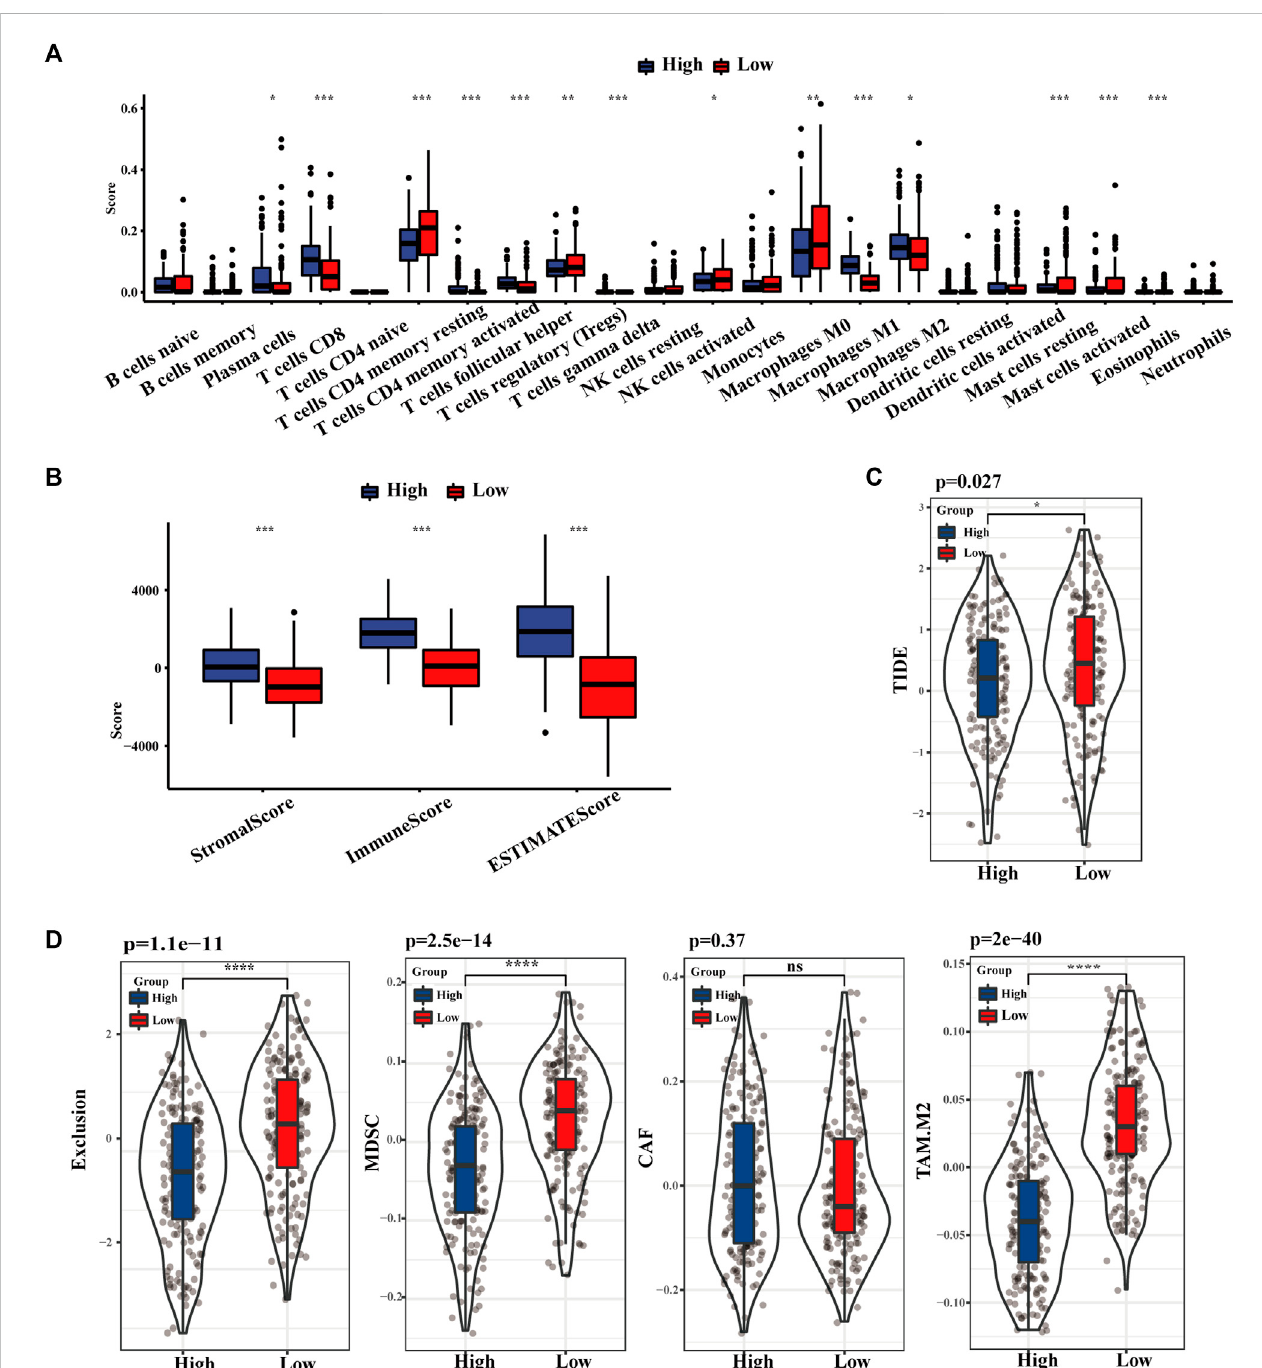
FIGURE 4 ThelandscapeofImmunein fi ltrationbasedonTLSsignature. (A) Thedistributionof28immunecellsbetweenhighandlowTLSsignaturegroups. (B) Box plots of TLS signature score in stromal, immune, and estimate score. (C) Violin plot of the differences in calculated TIDE scores between high and low TLS signature groups. (D) Differences in immune escape mechanisms and immunosuppressive cells between the two groups of TIDE. (NS: no signi fi cance, p p < .05, pp p < .01, and ppp p <